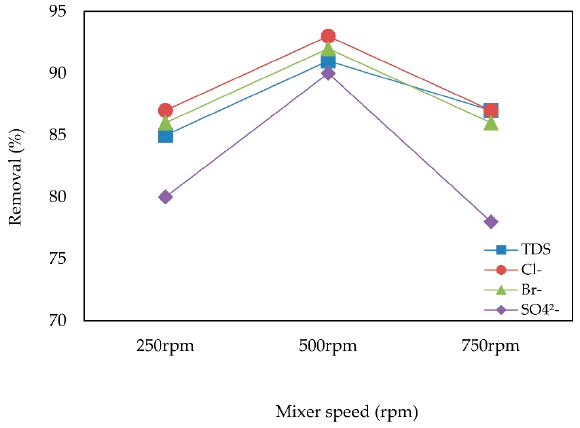
Figure 8. E ff ect of mixer speed under optimal conditions (I = 2.0 mA / cm 2 , RT = 80 min, pH = 8, Figure 8. Effect of mixer speed under optimal conditions (I = 2.0 mA/cm 2 , RT = 80 min, pH = 8, t = 25 °C, IED = 1cm). t = 25 ◦ C, IED =